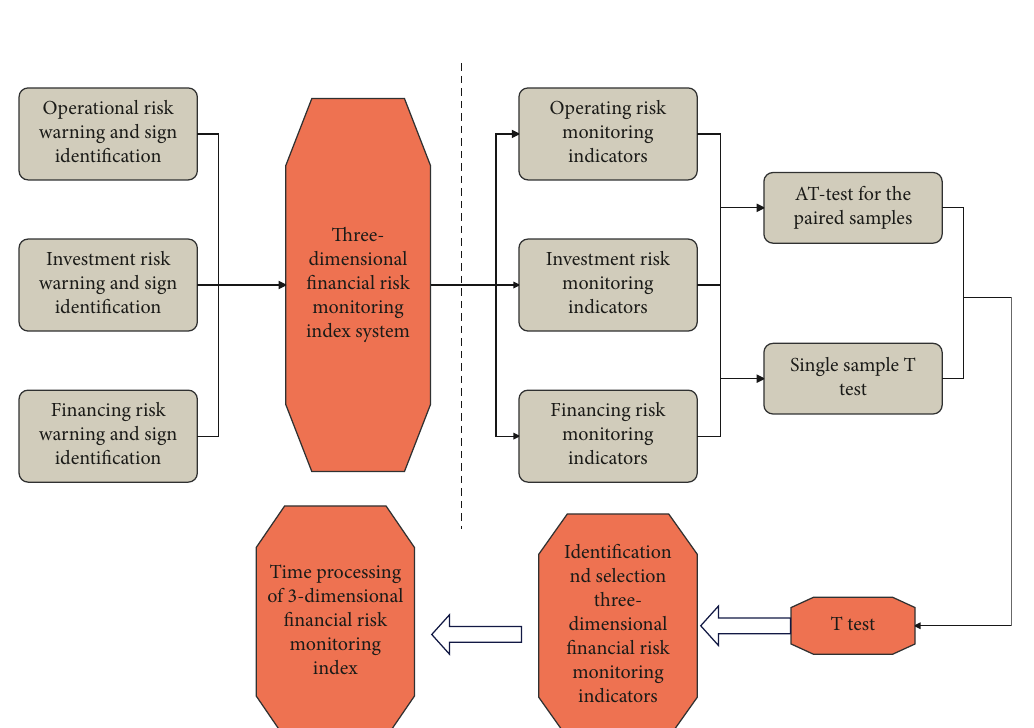
Figure 5: Logical framework of selection of three-dimensional financial risk monitoring